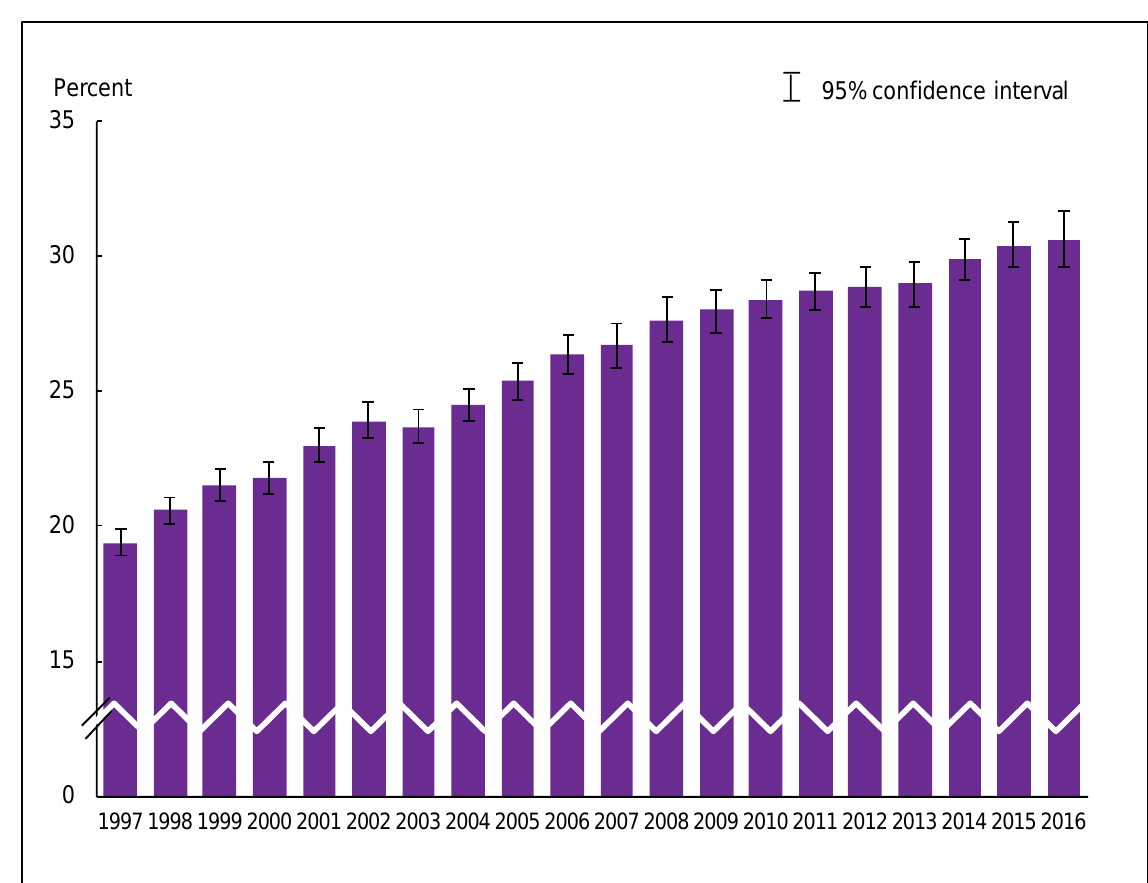
Figure 6.1. Prevalence of obesity among adults aged 20 and over: United States, Obesity